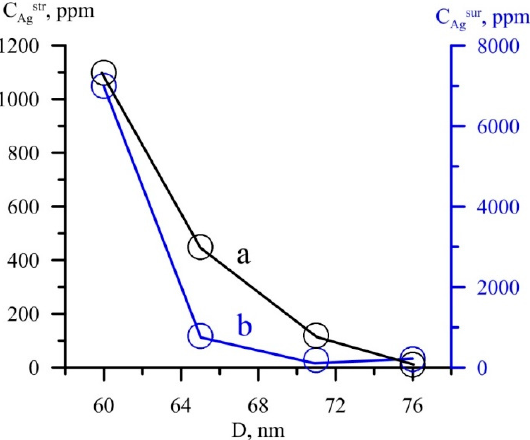
Figure 12. Dependences of Ag content in structurally ( a ) and superficially ( b ) bound modes on crystallite sizes in pyrite crystals. See Tables 3 and 4 for numerical data.